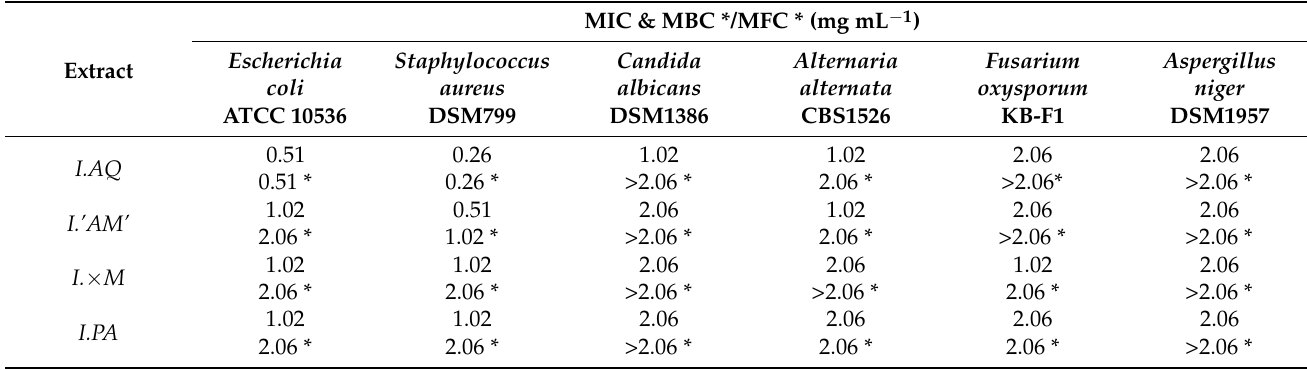
Table 4. Minimum inhibitory concentration (MIC) and minimum bactericidal/fungicidal concentration (MBC/MFC *) of Ilex water extracts (average from three experiments).